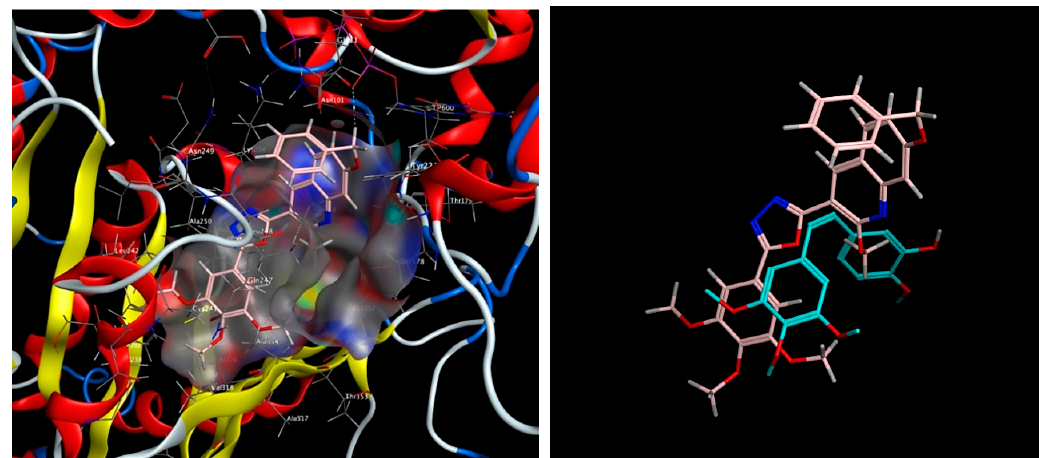
Figure 9. Quinoline 20j (pink) and CA-4 (cyan/light blue) docked at the colchicine-binding site of tubulin in co-crystal 1SAO. Protein residues removed on right for clarity. (red = oxygen, grey = hydrogen).